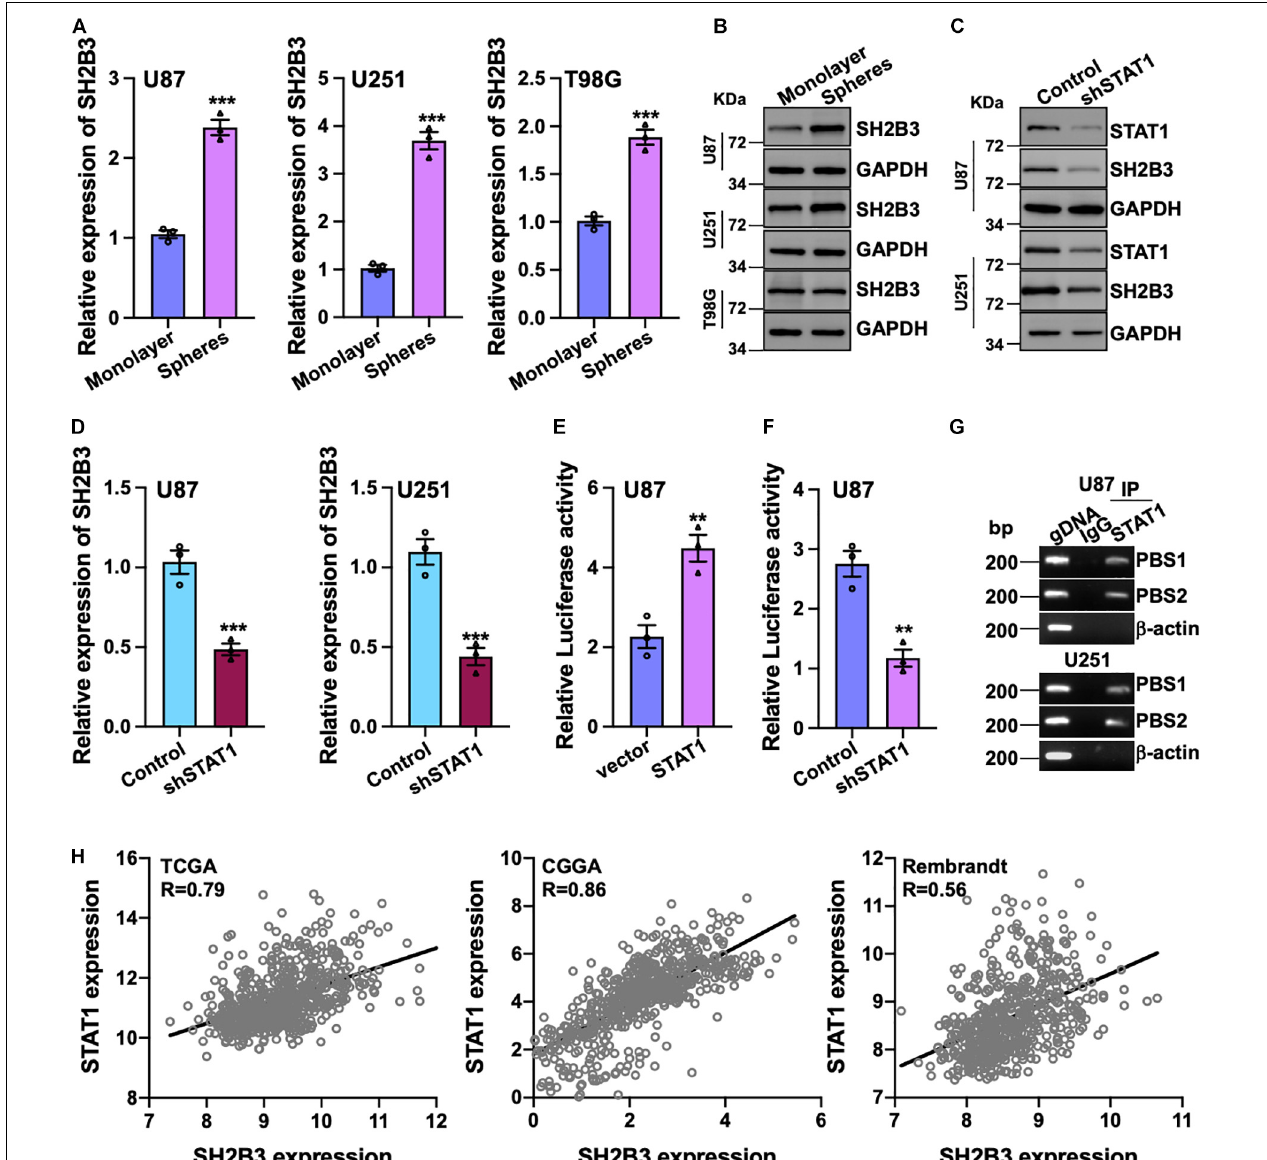
FIGURE 2 | SH2B3 is a direct transcriptional target gene of STAT1. (A,B) Both mRNA (A) and protein (B) levels of SH2B3 were increased in tumor spheres derived from indicated cells compared with their corresponding monolayer cells. (C,D) Silencing of STAT1 decreased both SH2B3 protein (C) and mRNA (D) levels. (E) Luciferase activity of vector containing SH2B3 promoter in response to depletion of STAT1. (F) Luciferase activity of vector containing SH2B3 promoter in response to overexpression of STAT1. (G) STAT1 directly binds to SH2B3 promoter determined by Ch-IP assay. PBS means potential binding site. BP means base pair. β -Actin promoter was used as a negative control. gDNA (genomic DNA) was used as a positive control. (H) STAT1 mRNA expression was positively correlated with SH2B3 mRNA expression in the indicated data set. *, **, and *** indicate p < 0.05, p < 0.01, and p < 0.0001,